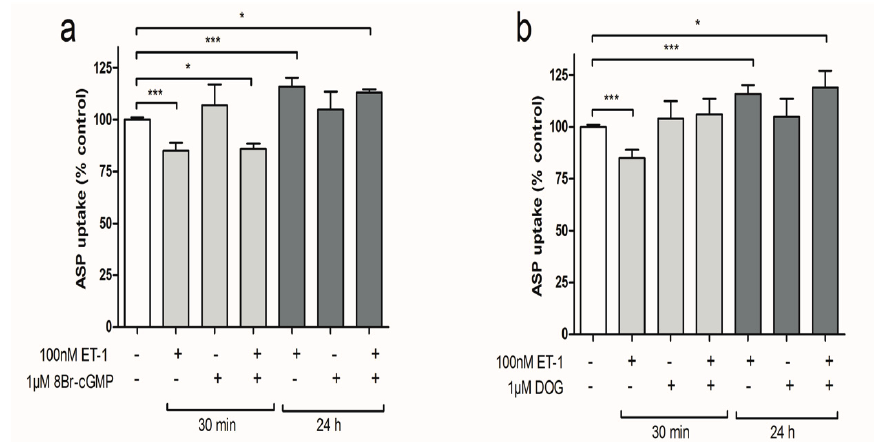
Figure 5. Kinase pathways on ciPTEC ASP+ uptake levels after exposure to ET-1. ciPTEC monolayers were incubated for 15 min in medium containing 10 µM ASP + without or with pre-incubation with ( a ) 100 nM ET-1, 1 μ M DOG or ET-1 plus DOG; ( b ) 100 nM ET-1, 1 μ M 8-br-cGMP or ET-1 plus 100µM 8-br-cGMP. Subsequently,